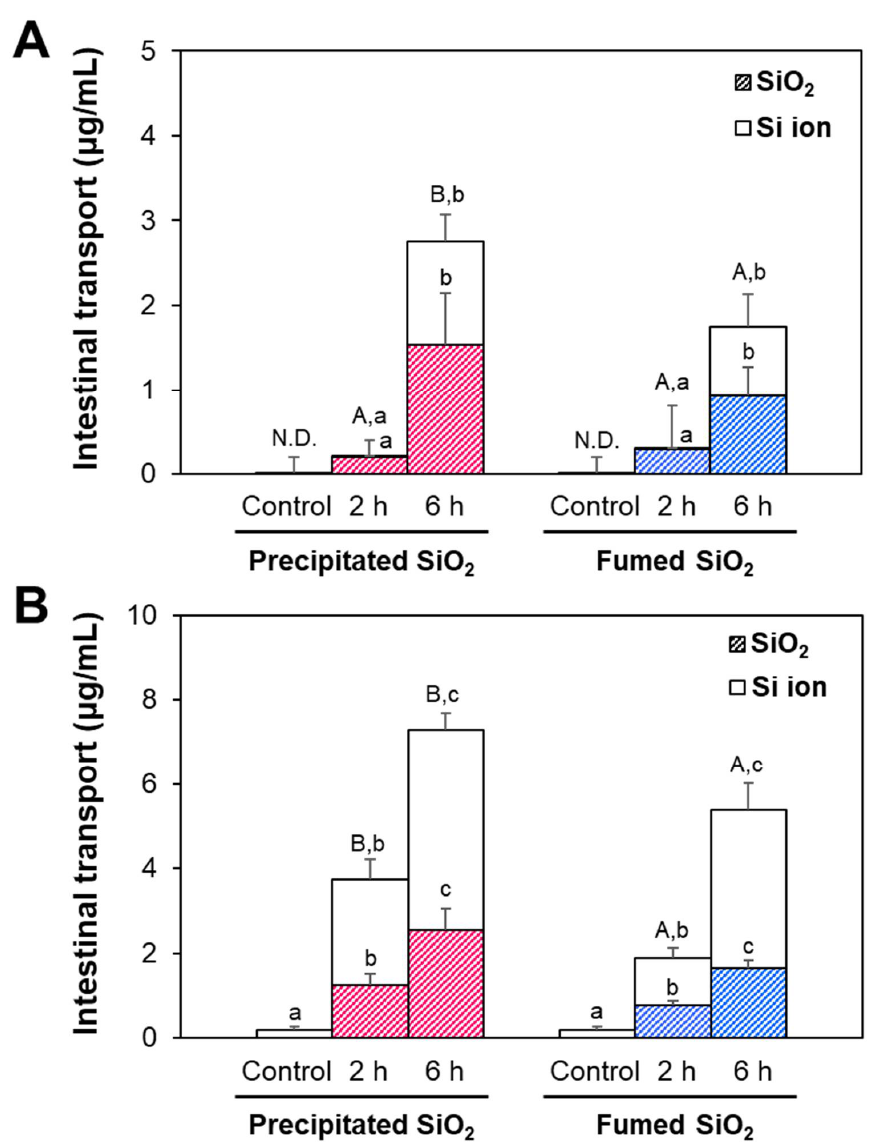
Figure 6. Intestinal transports and fates of SiO 2 using ( A ) in vitro Caco-2 monolayer and ( B ) follicle- associated epithelium (FAE) models, obtained via cloud point extraction (CPE). Different uppercase letters (A,B) indicate significant differences in total Si transport levels between precipitated SiO 2 and fumed SiO 2 ( p < 0.05). Different lowercase letters (a,b,c) indicate significant differences between different incubation times ( p < 0.05). ND: not detectable.